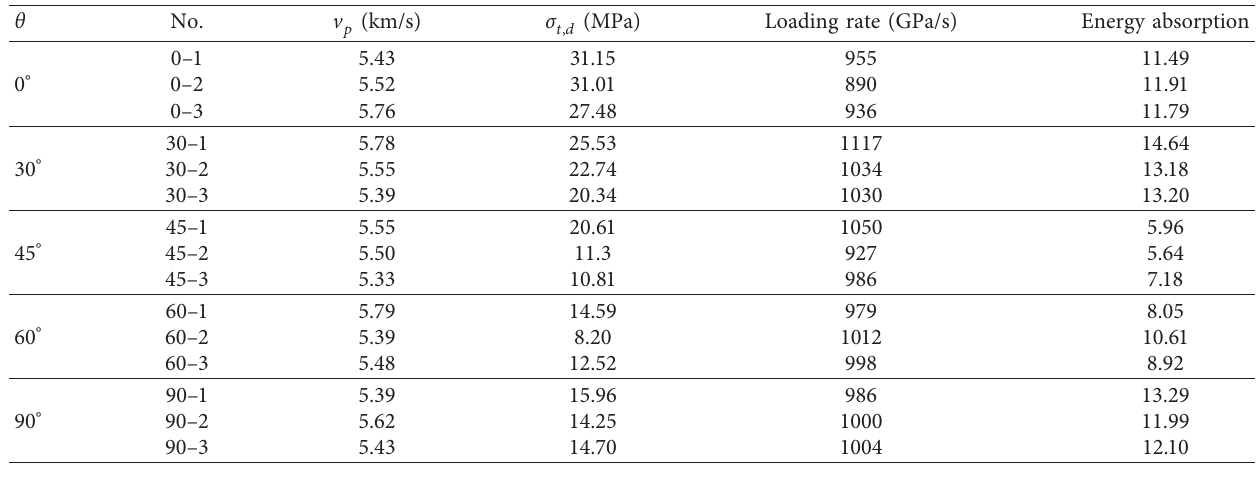
Figure 9: Ratio of bedding crack length to total crack length. Table 3: Dynamic Brazilian test results of the slate.